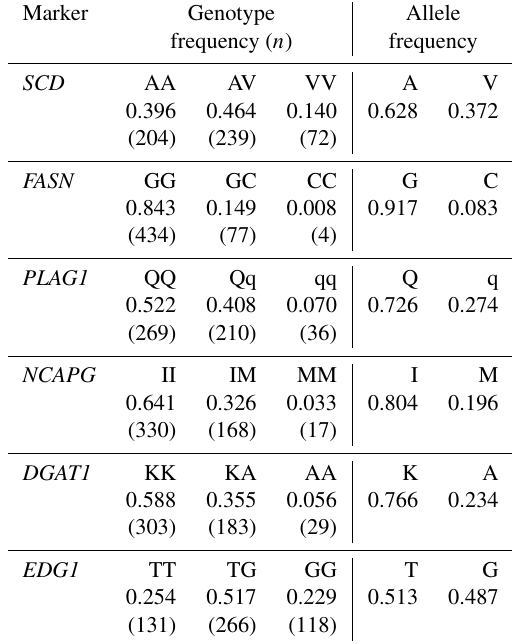
Table 3. Genotype and allele frequency of each marker in the Japanese Black cattle population ( n =